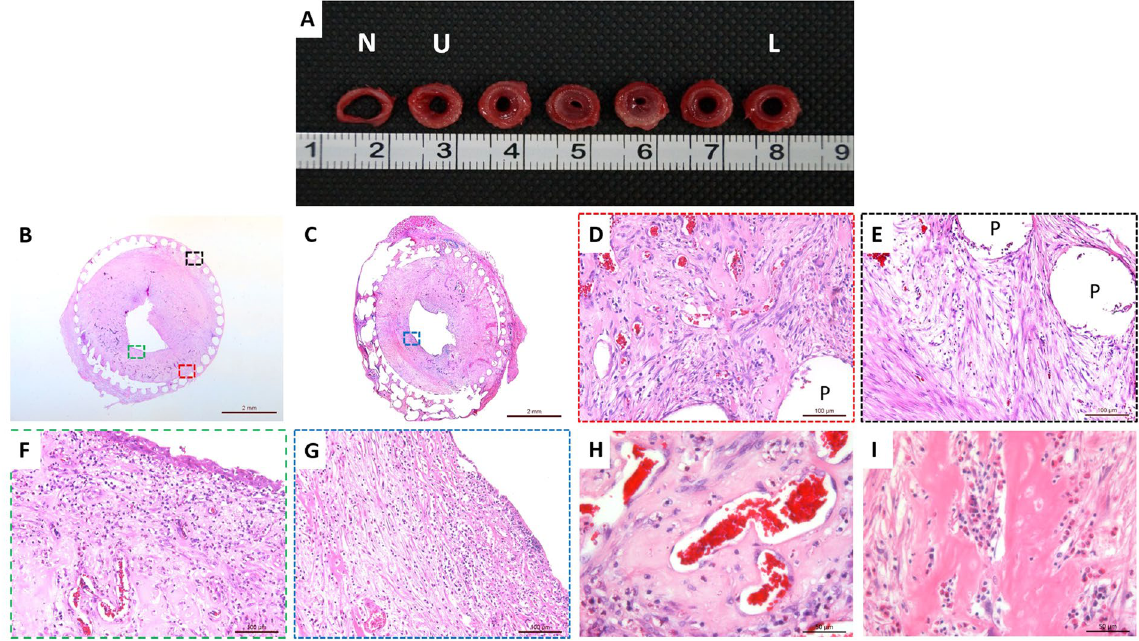
Figure 9. Representative photomicrograph and histological stainings of tissue-engineered trachea after trachea replacement surgery. ( A ) Granulation formation at each convolution throughout a scaffold segment. Note severe stenosis most obvious in middle convolutions ( B ) H&E staining of TET at 3 weeks-post implantation. ( C ) H&E staining of TET at 10 weeks-post implantation. ( D ) Enlarged photomicrograph revealing cartilage-like tissue in the outer layer of the scaffold. ( E ) Enlarged photomicrograph depicting the fibrous-like tissue present in the outer layer of the scaffold. ( F ) Photomicrogaph depicting lack of epithelial infiltration in luminal region at 3 weeks-post transplantation. ( G ) Photomicrograph depicting no evidence of epithelial infiltration at 10 weeks- post transplantation. ( H , I ) High resolution imaging depicting vascularization and infiltrating inflammatory cells within the scaffold, respectively. Scalar bars: ( B and C ), 2 mm, ( D – G ) 100 μ m, ( H and I ) 50 μ m. (N: native